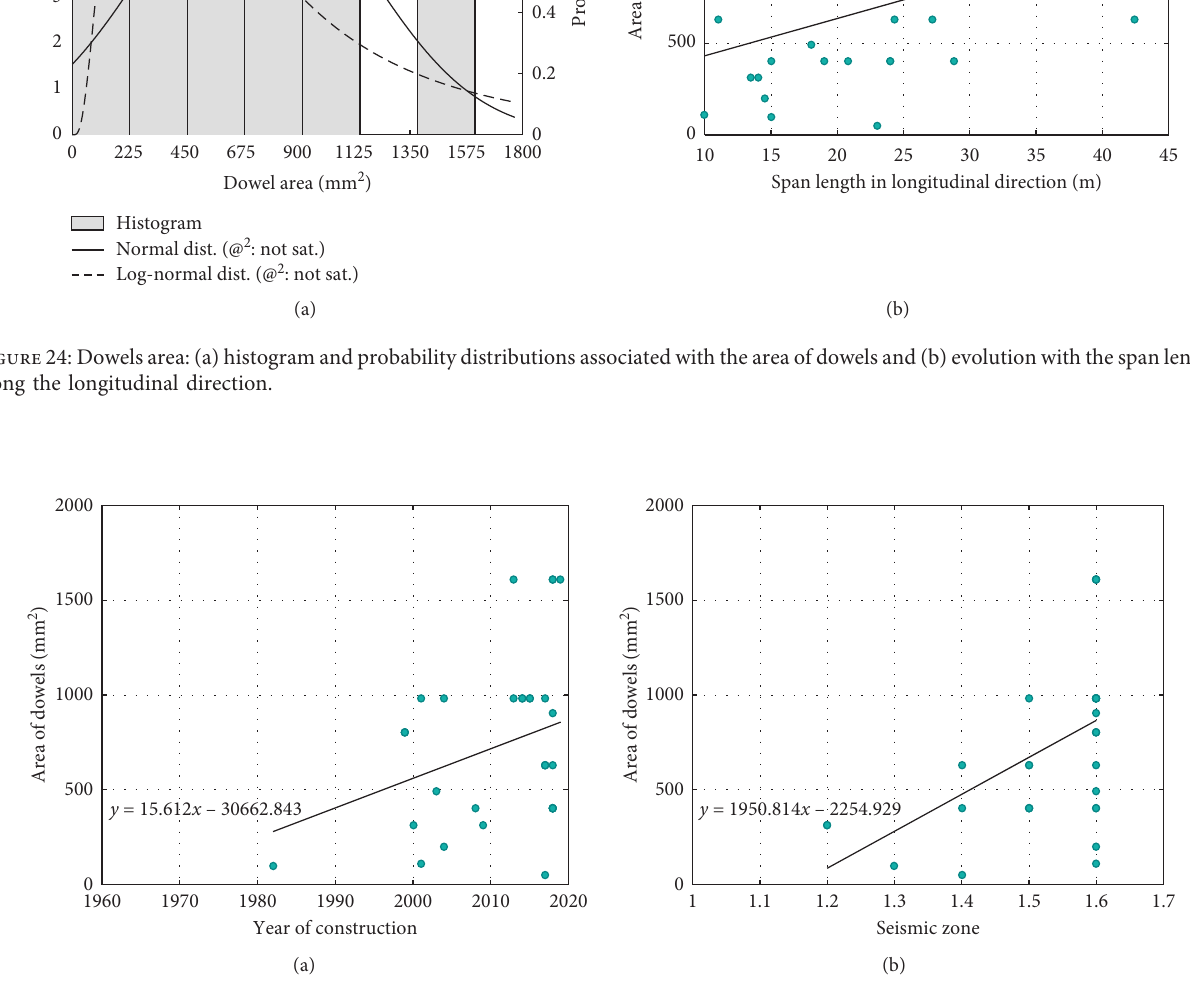
Figure 25: Evolution of dowels area in beam-to-column connections with the (a) year of construction and (b) seismic